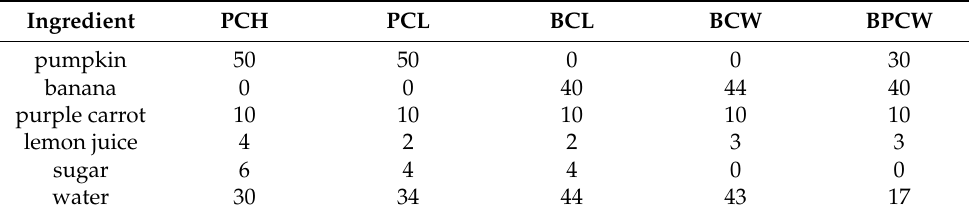
Table 5. Smoothie compositions (g/100